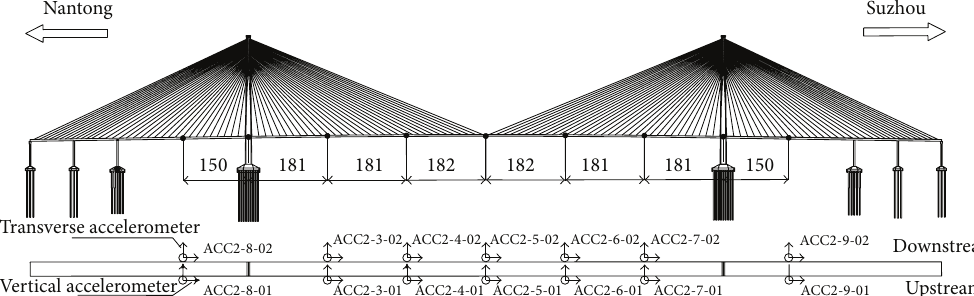
Figure 14: Layout of sensors for deck vibration monitoring in SCB.